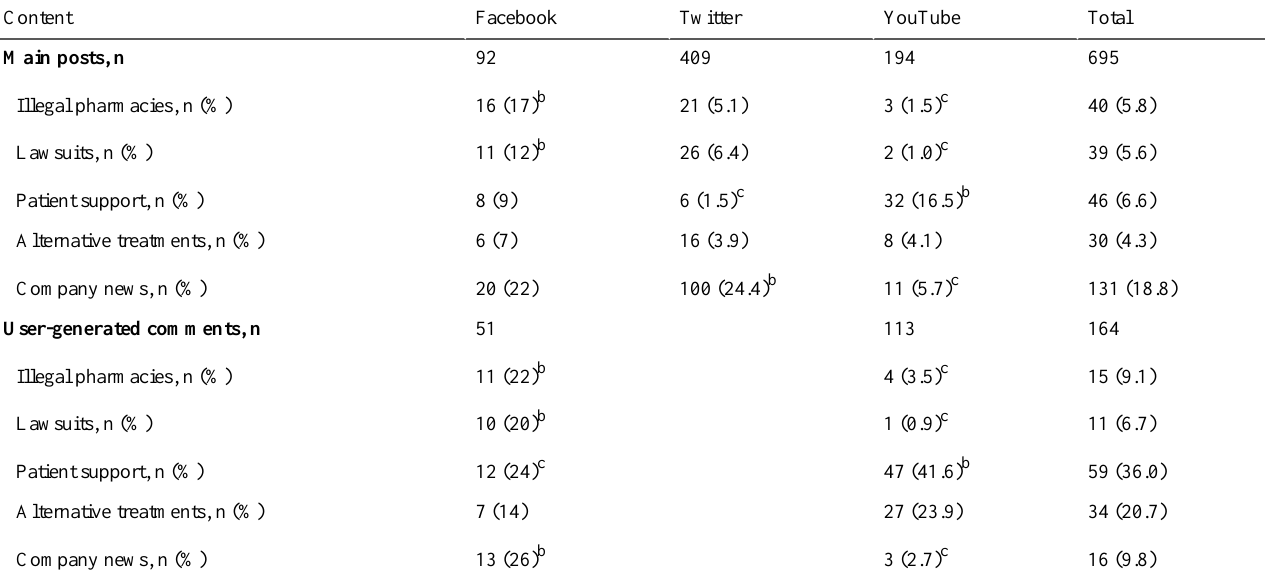
Table 6. Other content in drug-specific analysis. a